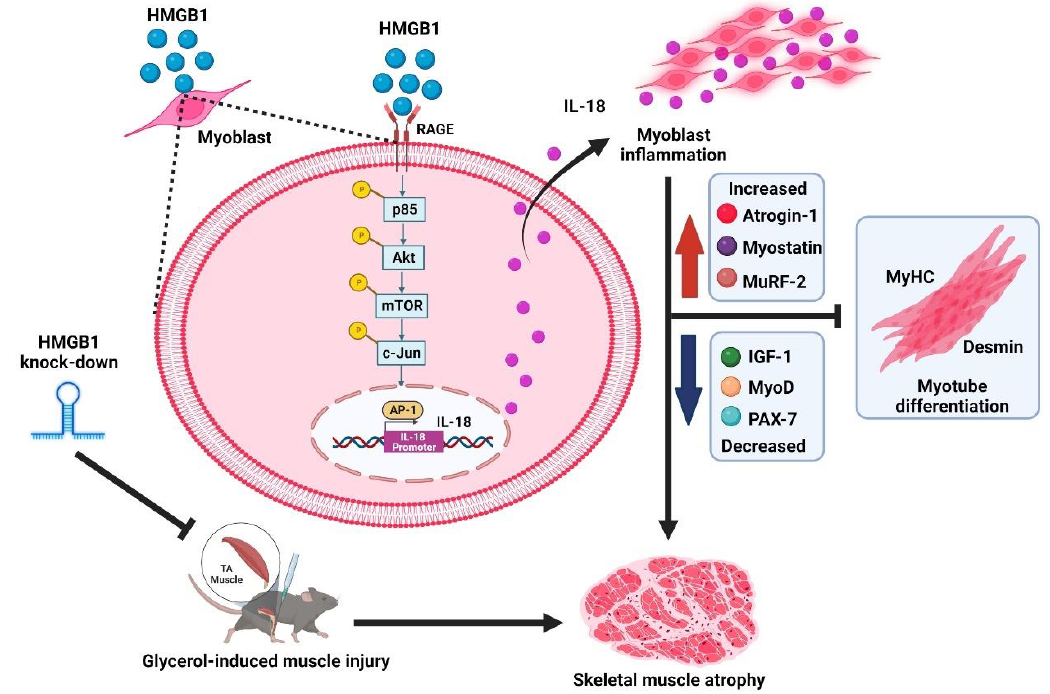
Figure 7. Schematic diagram illustrating the in vitro and in vivo effects of the HMGB1/IL-18 axis upon skeletal muscle atrophy.